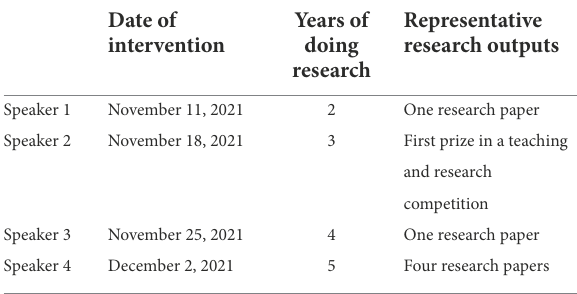
TABLE 2 Details of the four interventions and four role